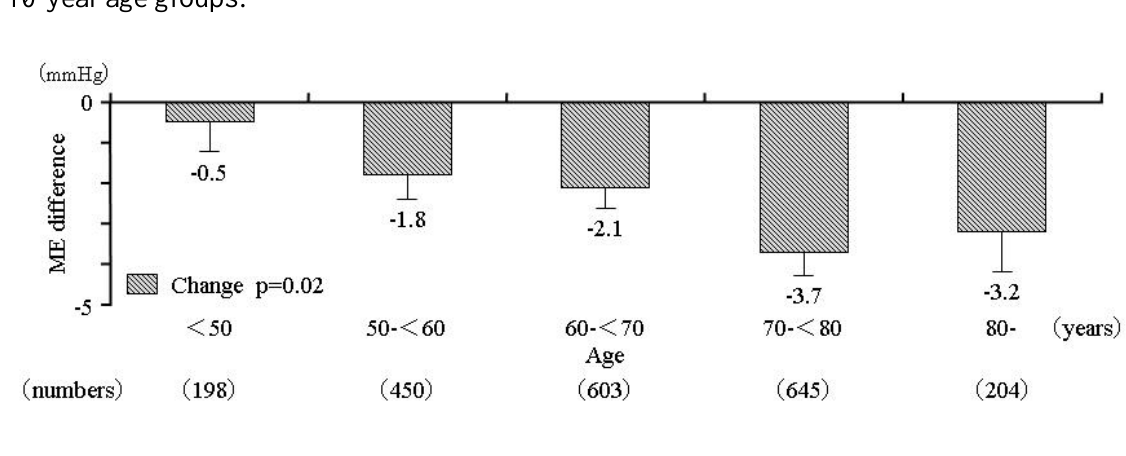
Figure 4. Change of ME-Dif from baseline after treatment with AZ in patients stratified by 10-year age groups.